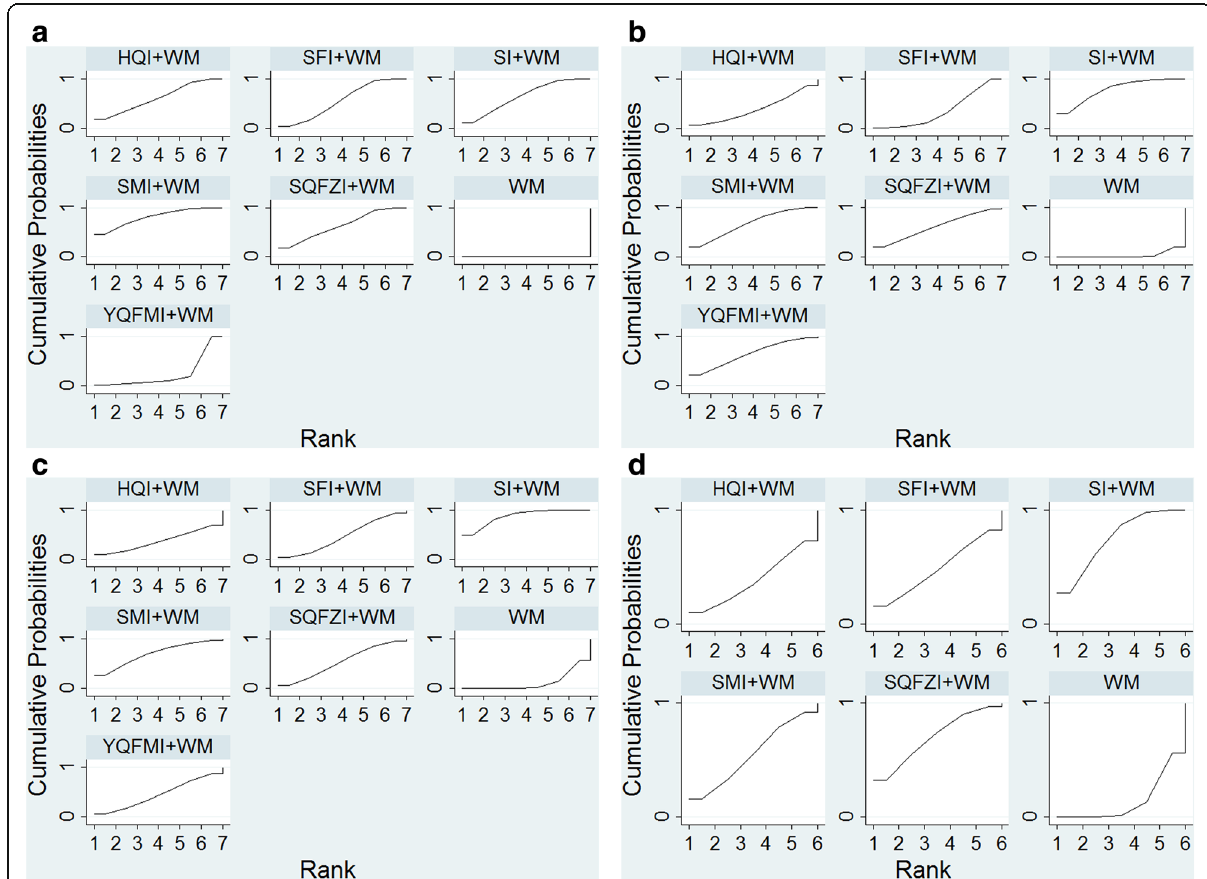
Fig. 4 Plot of the surface under the cumulative ranking curves for all treatments on the clinical effective rate, LVEF, CO and SV. Note: a : the clinical effective rate; b : LVEF; c : CO; d :